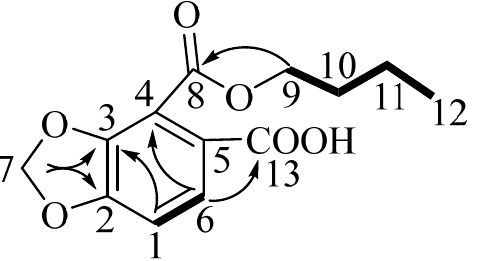
Figure 2. Key HMBC and 1 H- 1 H COSY correlations for compound 1 .